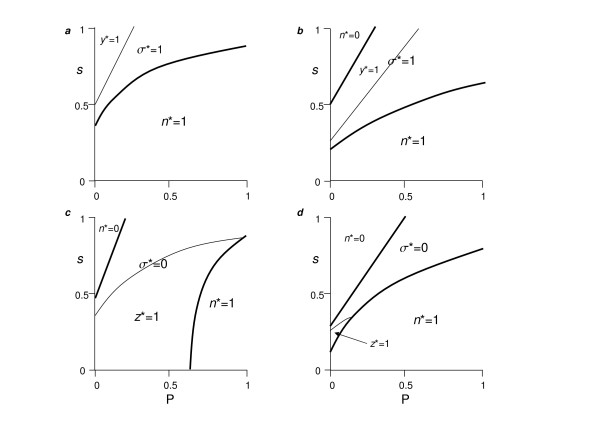
Locally optimal associations between dispersal and exploitation strategy. The frequency of dispersal in cooperators (y) and cheaters (z) evolves, and the frequency of cooperators (n) and cheaters (1-n) evolves. Initial frequencies in numerical studies: y = z = n = 0.5. As for Figure 1 except caption a: k = 1.2, c = 0.1; caption b: k = 10, c = 0.1; caption c: k = 1.2, c = 0.3; caption d: k = 10, c = 0.3.